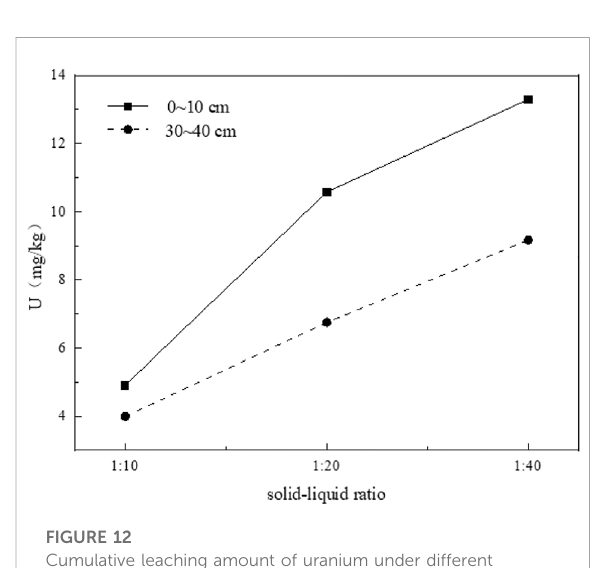
FIGURE 12 Cumulative leaching amount of uranium under different solid-liquid ratio